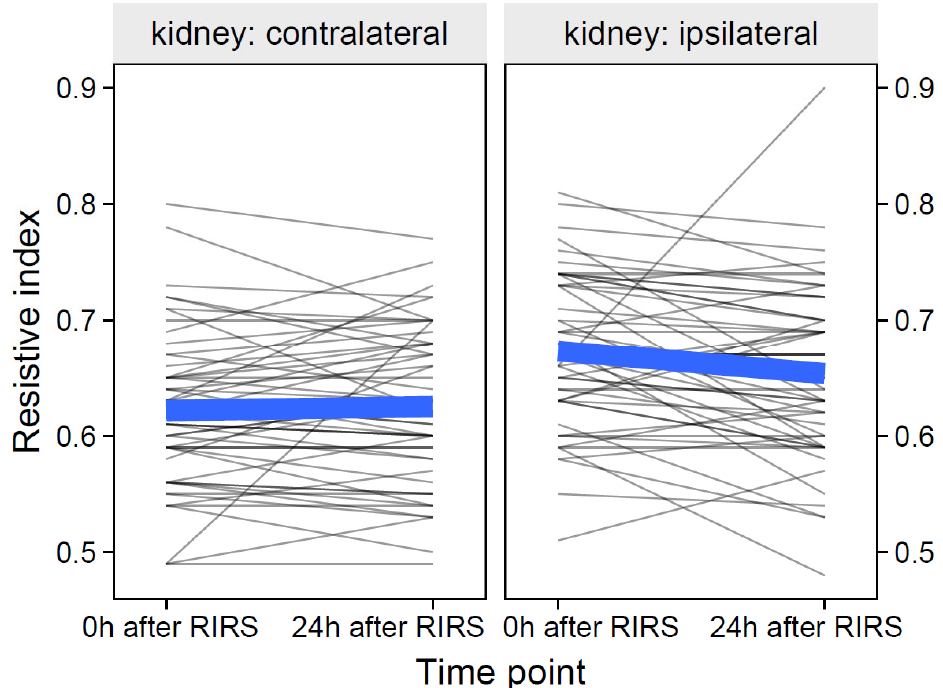
Figure 10. The effect of kidney side on resistive index over time (the thin, semitransparent black lines in the background are the individual-level data. The bold blue lines in the foreground are the group averages). The figure shows that the effects of the kidney side on the focal variable of the resistance index were obviously different over time. The inclusion of the effects of mean stone volume, energy used, pre-stenting, and kidney side at separate time points is presented in Sections